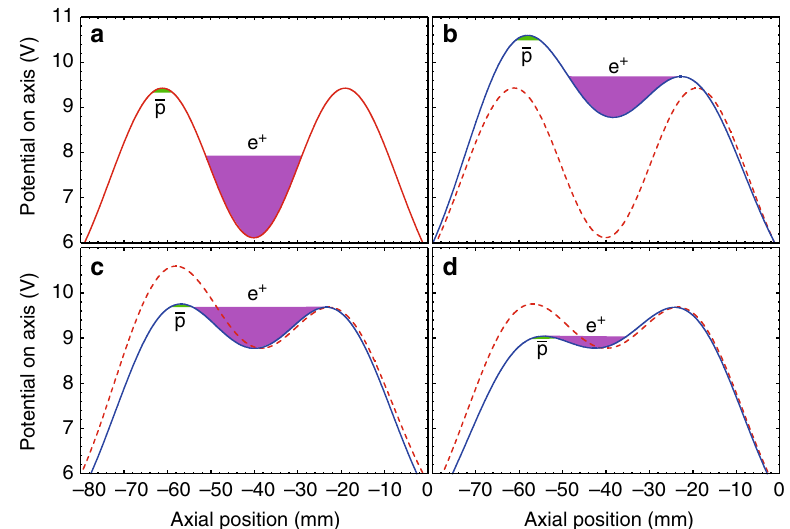
Fig. 2 Antihydrogen synthesis sequence. Dashed and solid curves represent electrostatic potentials before and after each step in the process. Filled regions indicate self-potentials and physical extents of antiproton and positron plasmas. a Potential before evaporative cooling. Positron well depth 3.31 V. b Evaporative cooling, during which energetic positrons escape to the right (duration 600 ms). Final positron well depth 0.91 V. c Potential realignment in preparation for mixing (duration 10 ms). Final positron well depth 0.91 V. d Potential merge mixing (duration 1 s). Positrons escape to the left during mixing, resulting in further evaporative cooling. Final positron well depth 0.27 V. Remaining positrons are ejected to the right for a temperature measurement; remaining antiprotons are ejected to the